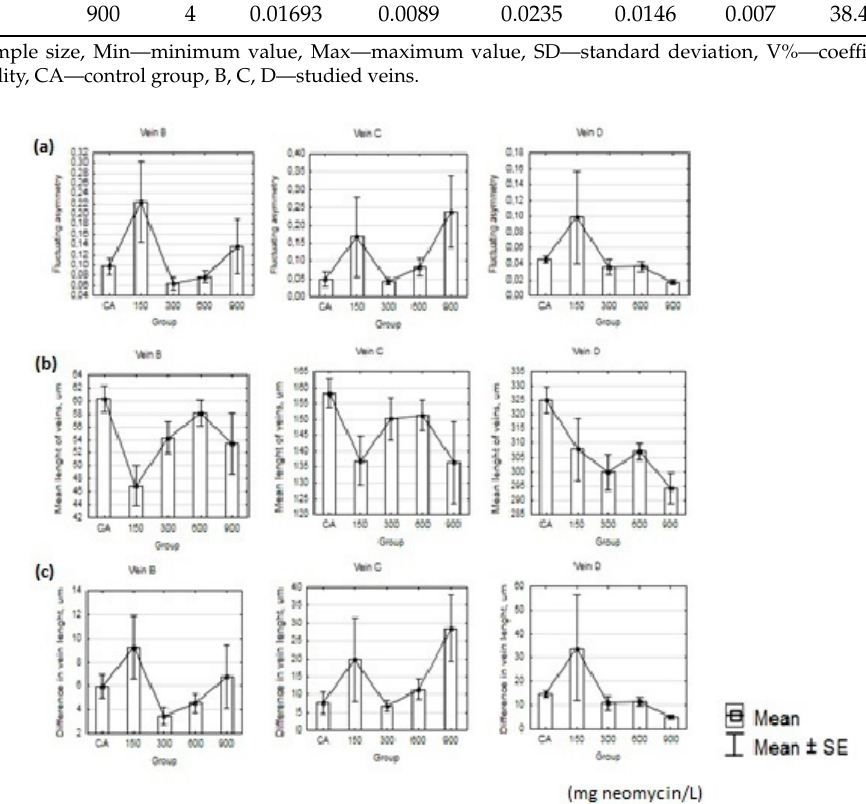
Figure 7. Graph of mean and standard error (SE) of fluctuating asymmetry ( a ), mean length of veins ( b ), and differences in vein length ( c ) for three studied veins.